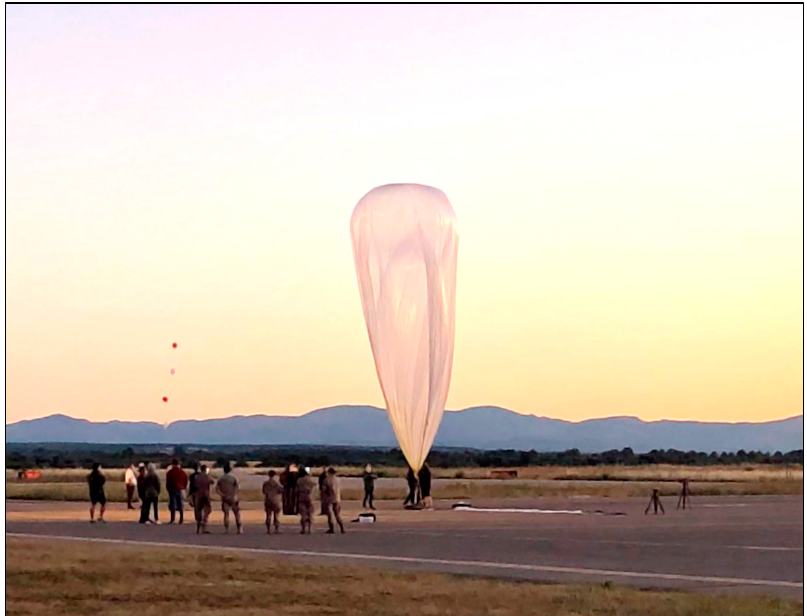
Figure 1. Launch of the TASEC ‐ Lab mission from the León (Spain) aerodrome, on the morning of 16 July 2021.